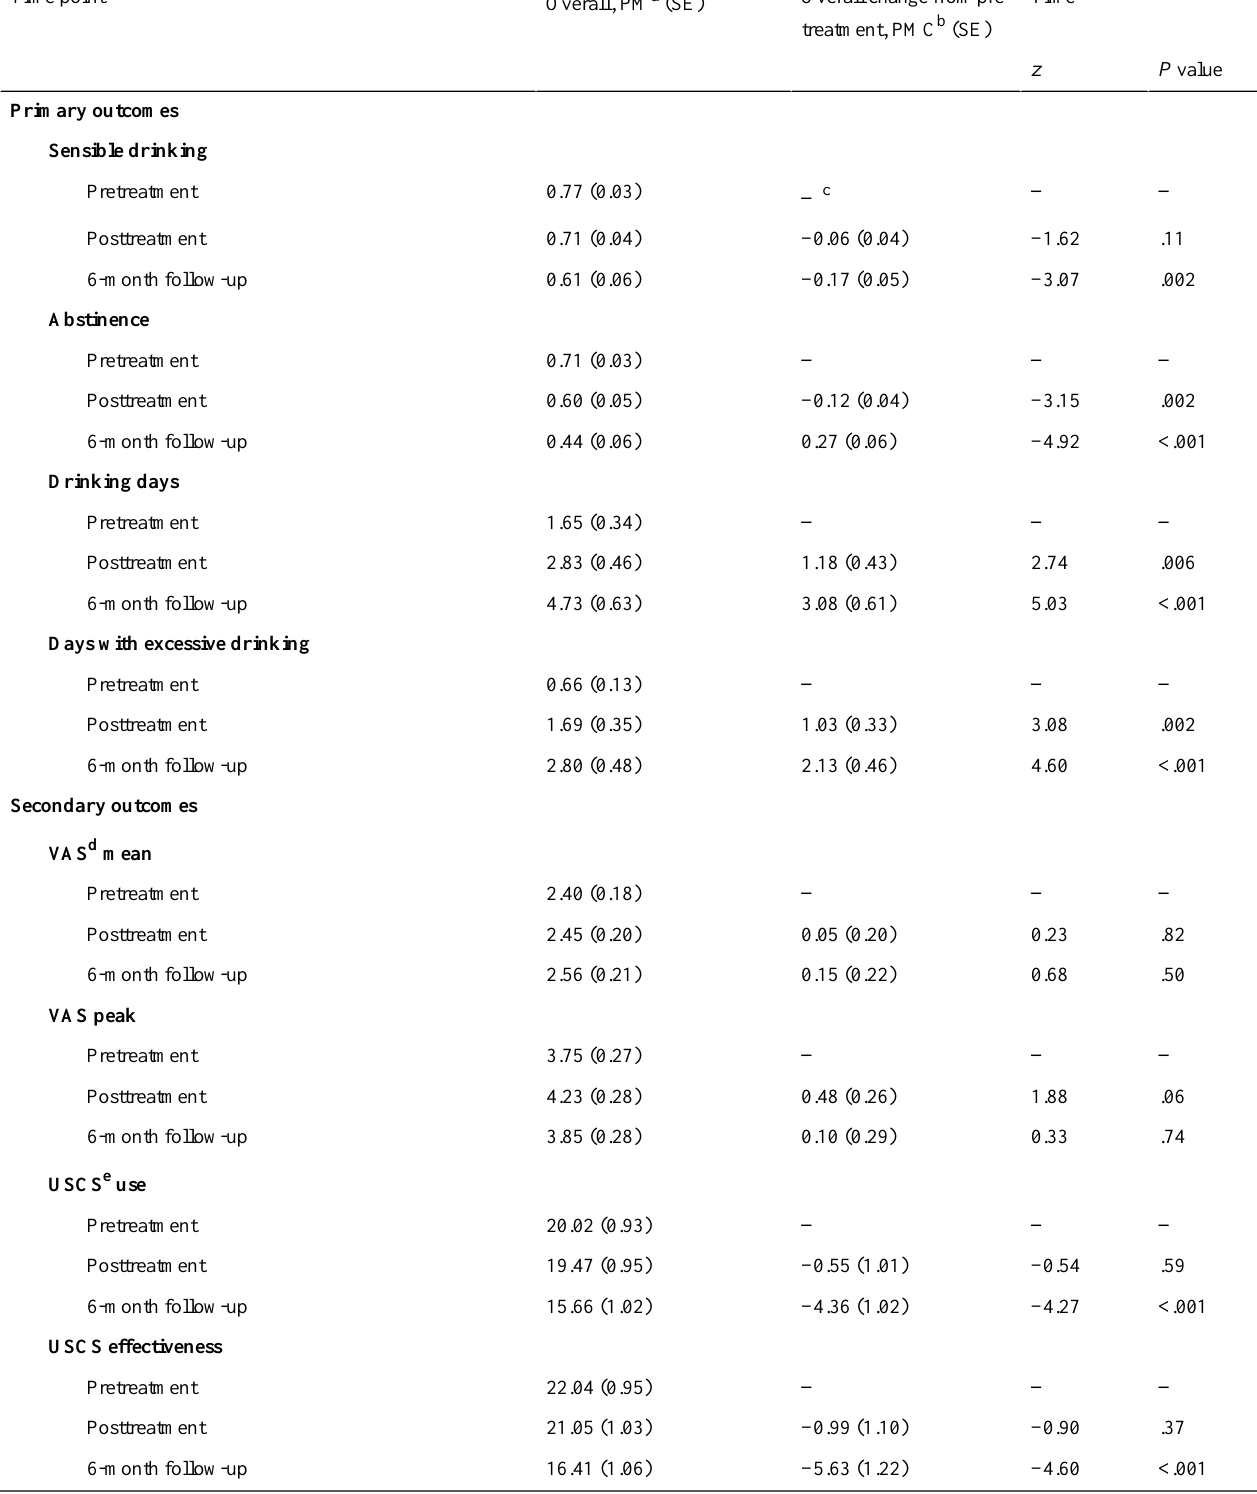
TimeOverall change from